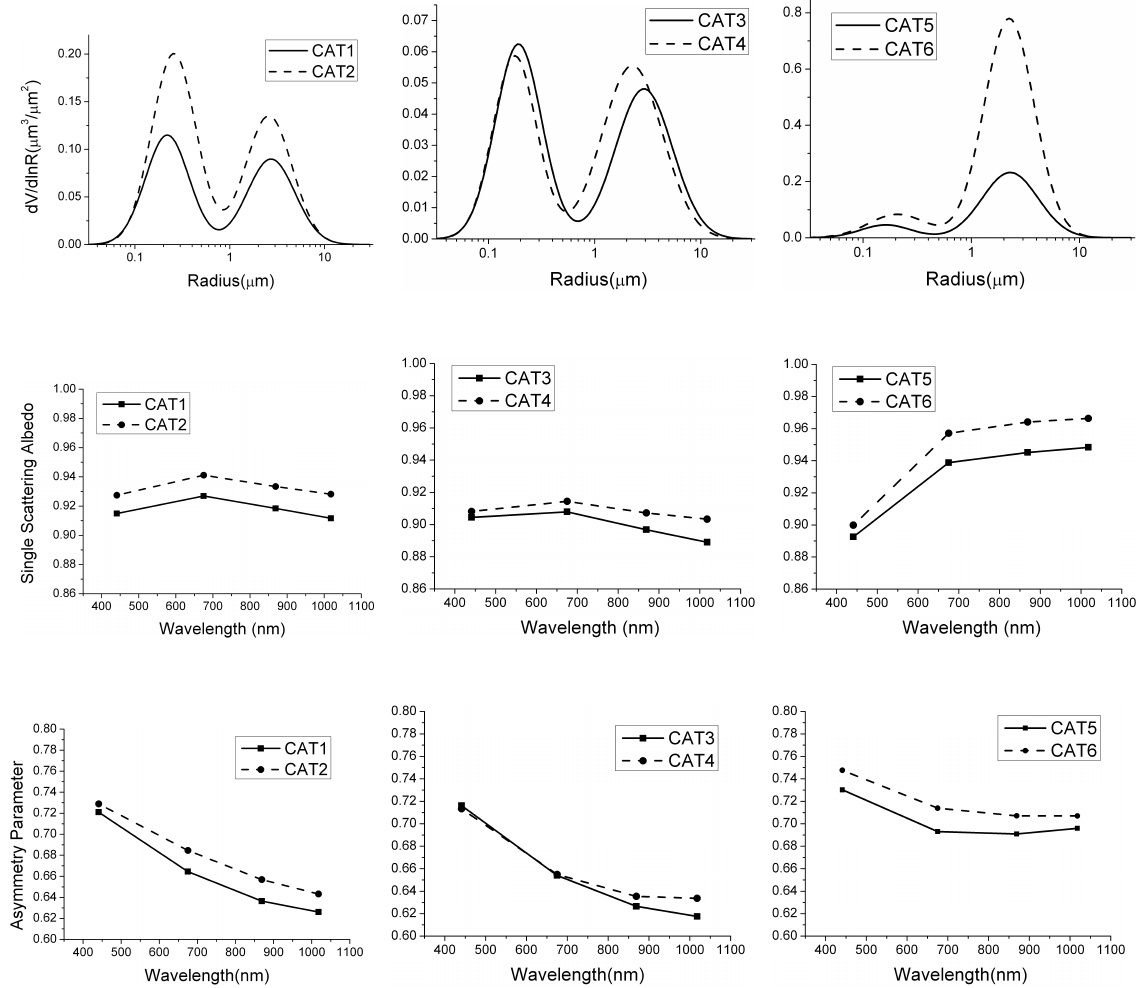
Fig. 2. Optical and microphysical properties of different types of aerosols classified from the AERONET inversion products.